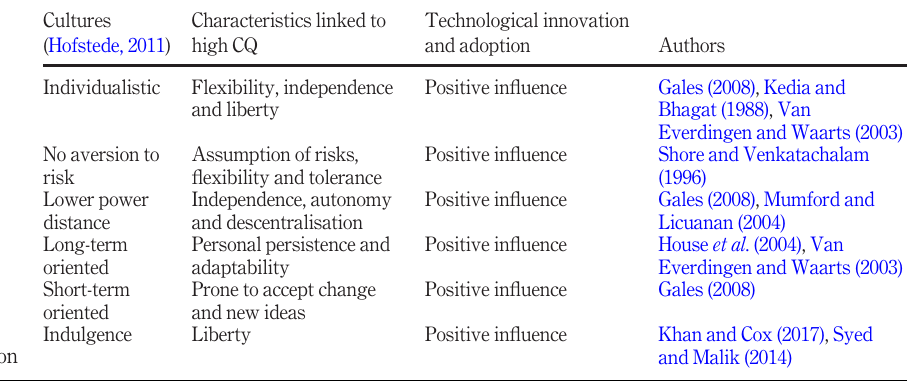
Table III. CQ, Cultural dimensions and technology